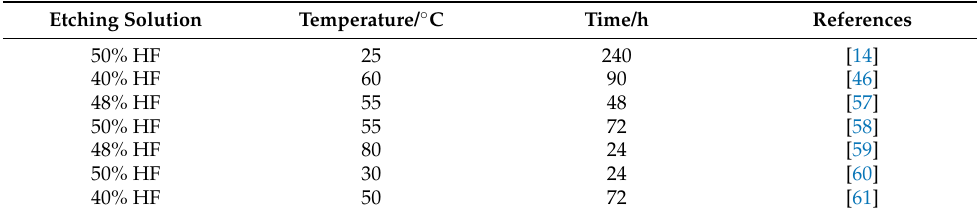
Table 1. Different parameters of HF etching method for the preparation of Nb 2 CT x